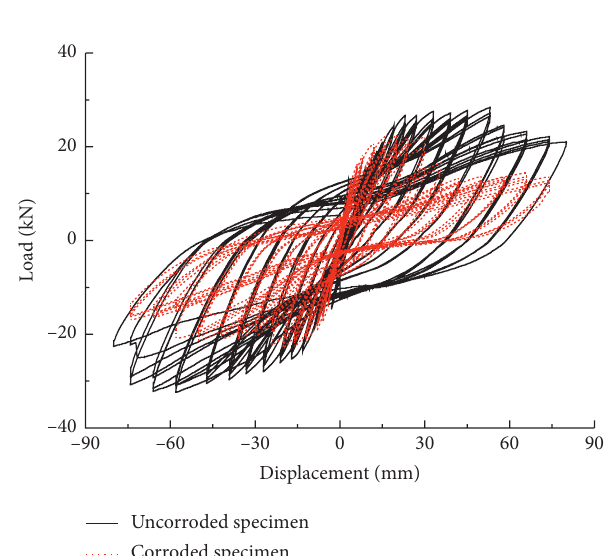
Figure 12: Comparison of hysteresis characteristics between the corroded specimen and uncorroded